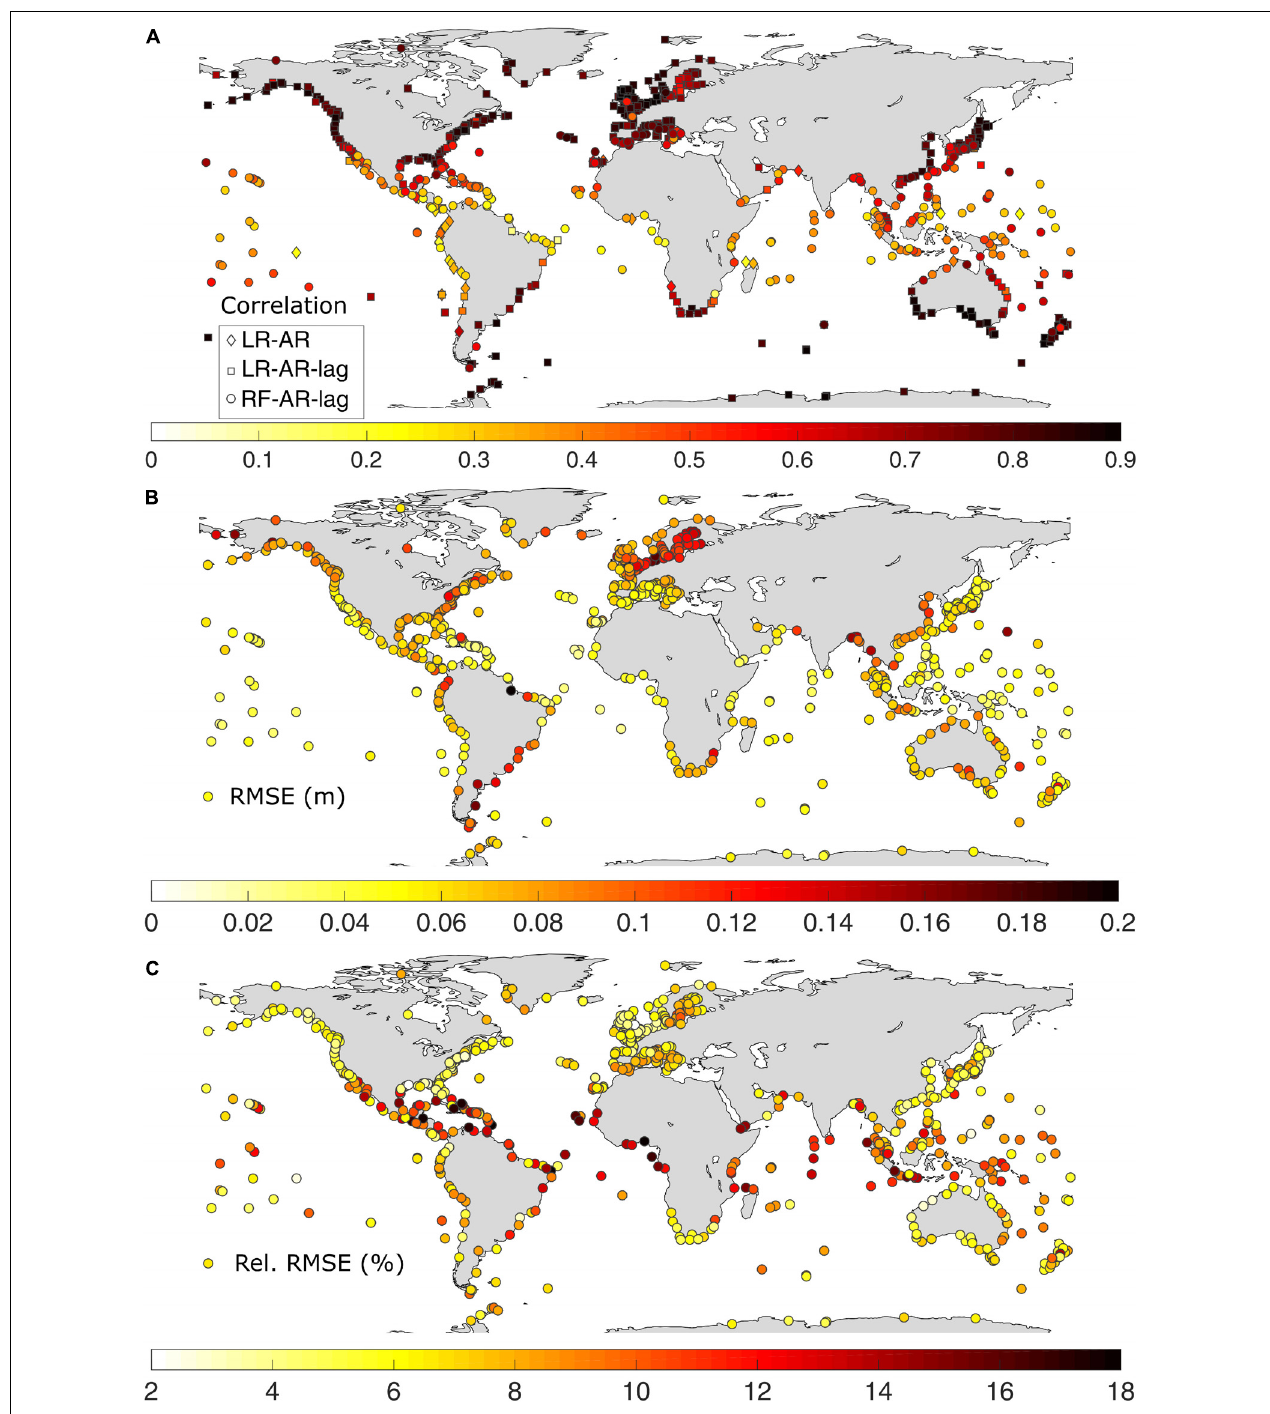
FIGURE 10 | Validation of modeled (Model-AR) daily maximum surge in terms of (A) Pearson’s correlation coefficient – diamonds, rectangles, and squares represent the three sub-models (LR-AR, LR-AR-lag, and RF-AR-lag) that make up Model-AR; (B) RMSE in m; and (C) relative RMSE in %.